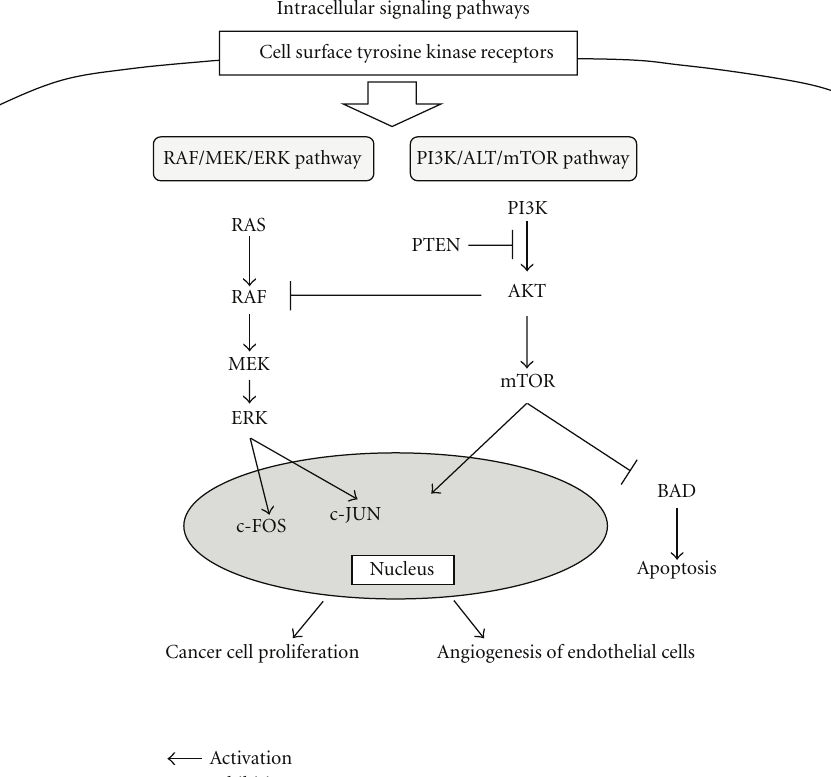
Figure 2: The RAF/MEK/ERK and the PI3K/AKT/mTOR signaling pathways are shown. Proangiogenic and proliferative growth factors activate the RAF/MEK/ERK pathway. The small GTPase RAS and the serine/threonine kinase RAF are the key molecular signal regulators. Intermediate signaling is regulated by MEK, which is responsible for phosphorylating and activating the final downstream signaling ERK molecules. ERK regulates cellular activity, indirect inducers of gene expression, and transcription factors in the AP-1 family such as c-JUN and c-FOS and cell cycle-related kinases. Binding of these growth factors to their receptors also activates PI3K, which subsequently produces the lipid second messenger, and in turn activates serine/threonine kinase AKT. Activated AKT also phosphorylates several cytoplasmic proteins, most notably mTOR. The activation of mTOR increases cellular proliferation, and inactivation of BAD decreases apoptosis and increases cell survival. This pathway is negatively regulated by the phosphatase and tensin homolog deleted on chromosome 10 (PTEN), which targets the lipid products of PI3K for